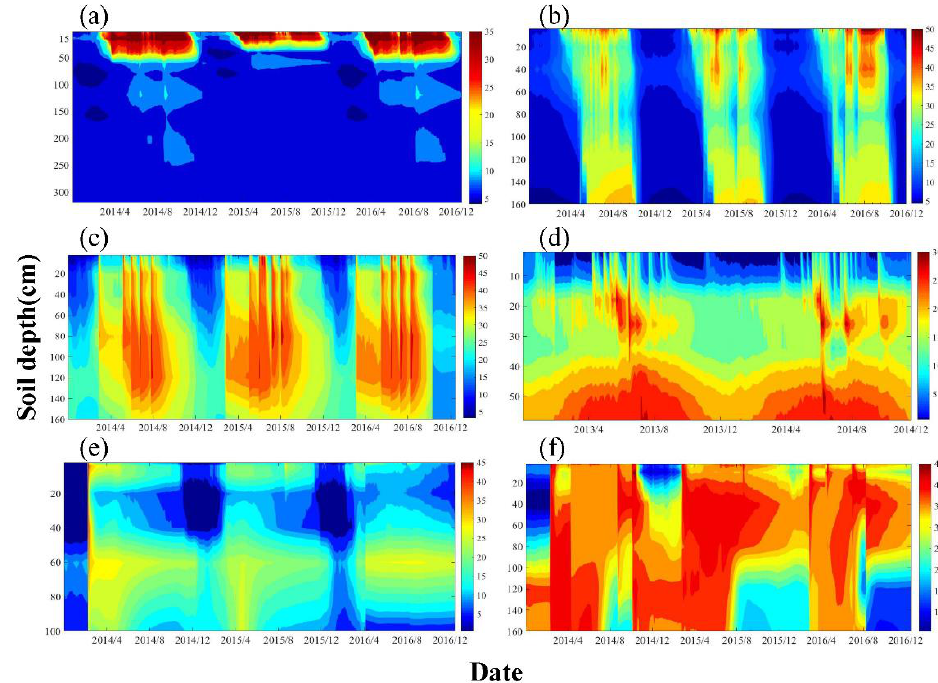
Figure 2. Spatial distribution of average daily soil moisture during study period for ( a ) alpine meadow; ( b ) alpine swamp meadow in 2014–2016; ( c ) cropland in 2013–2014; ( d ) Kalidium foliatum in 2013–2014; ( e ) P. euphratica in 2014–2015; ( f ) T. ramosissima in 2014-2016.